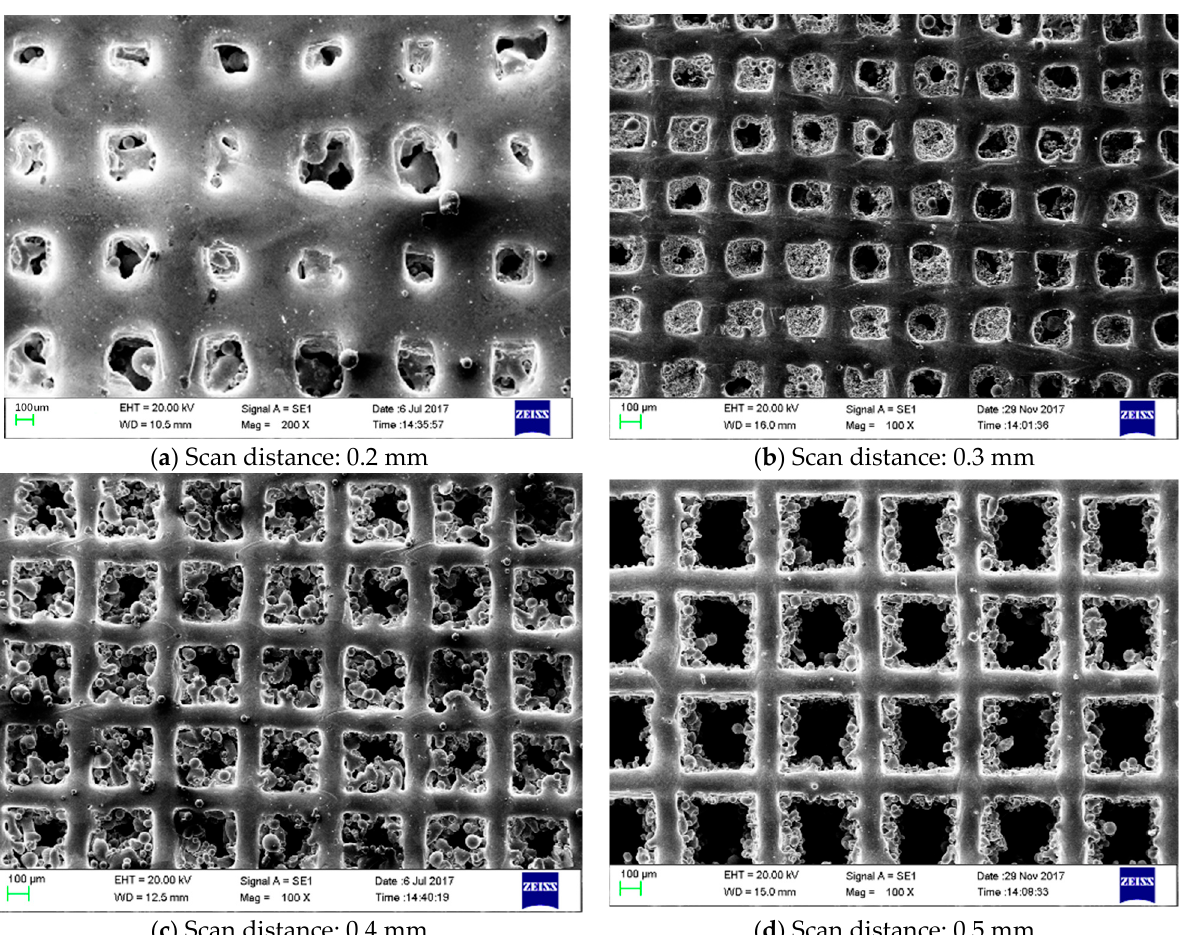
Figure 5. SEM images of the grid structures formed with 200 W of laser power and at different scan spacings.